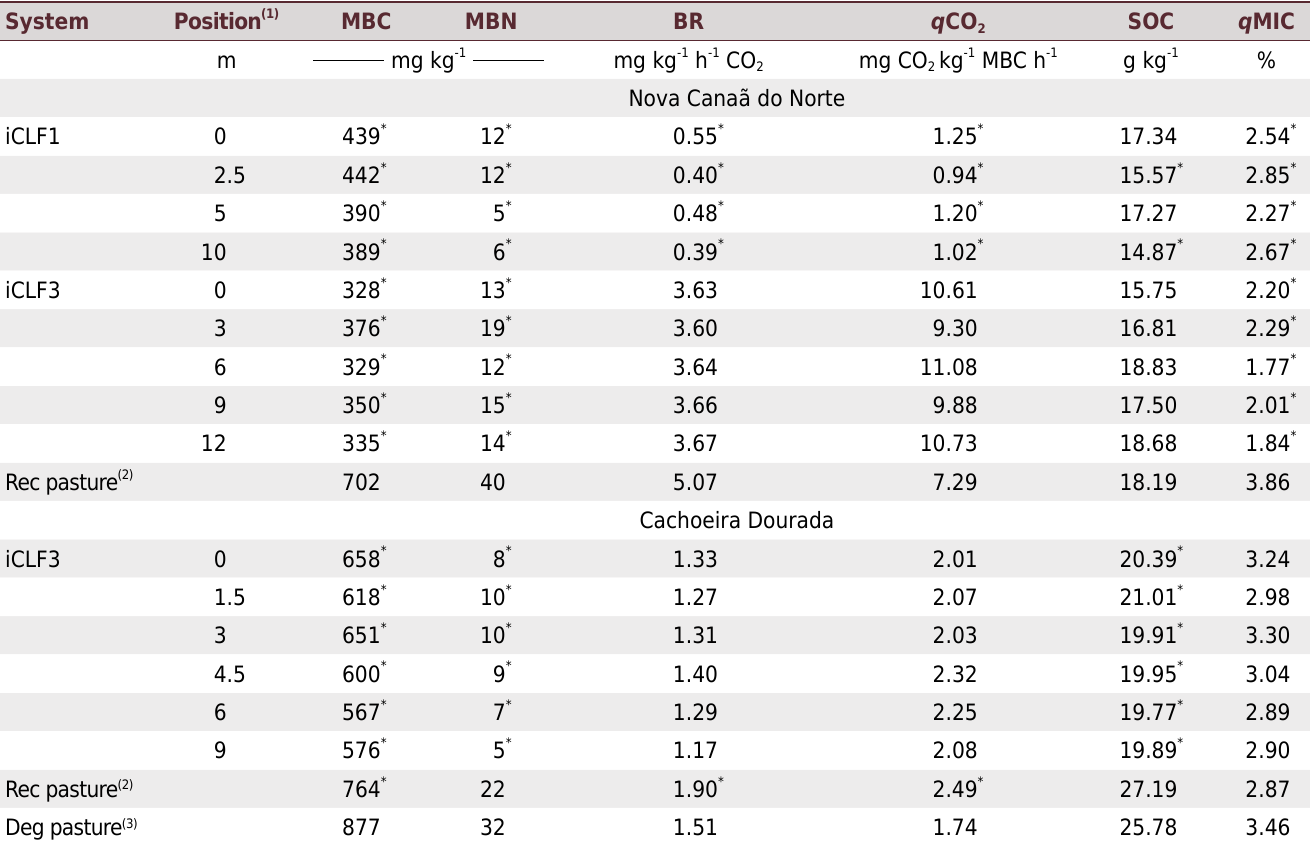
Table 2. Microbial biomass carbon (MBC), microbial biomass nitrogen (MBN), soil basal respiration (BR), metabolic quotient ( q CO 2 ), soil organic carbon (SOC) and microbial quotient ( q MIC), according to the systems and sampling positions studied in Nova Canaã do Norte, MT, and Cachoeira Dourada, GO, 2012